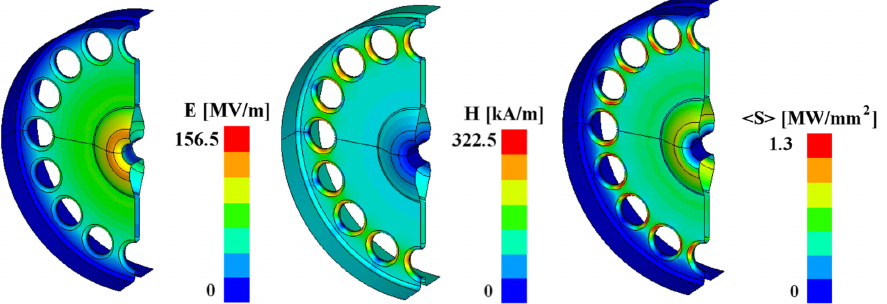
FIG. 11. Electric (left), magnetic (center) and modified Poynting vector (right) field maps in the optimized β ¼ 0 . 3 NHS cell.